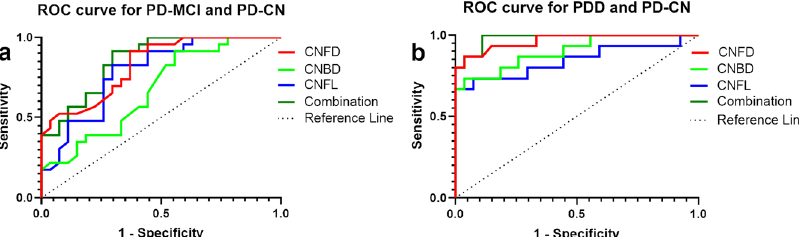
Fig. 6 The ROC for CCM parameters to distinguish PD-MCI and PDD from PD-CN. The accuracy of ROC predicting PDD ( b ) was higher than PD-MCI ( a ). Abbreviations: ROC receiver operating characteristic, CNFD corneal nerve fi ber density, CNBD corneal nerve branch density, CNFL corneal nerve fi ber length, PD-MCI Parkinson ’ s disease with mild cognitive impairment, PDD Parkinson ’ s disease with dementia, PD-CN Parkinson ’ s disease with normal cognitively function, AUC area under the